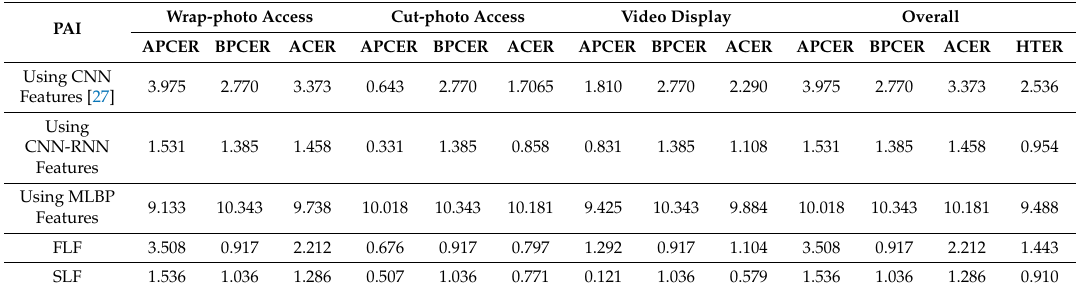
Table 6. Detection errors (APCER, BPCER, ACER, and HTER) of our proposed method with the CASIA dataset using three types of PAI (unit: